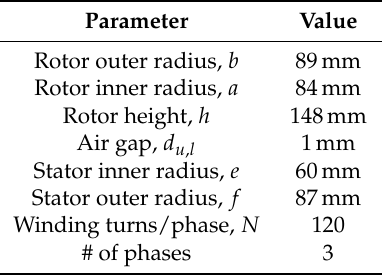
Table 2. Dimensions of the prototype.